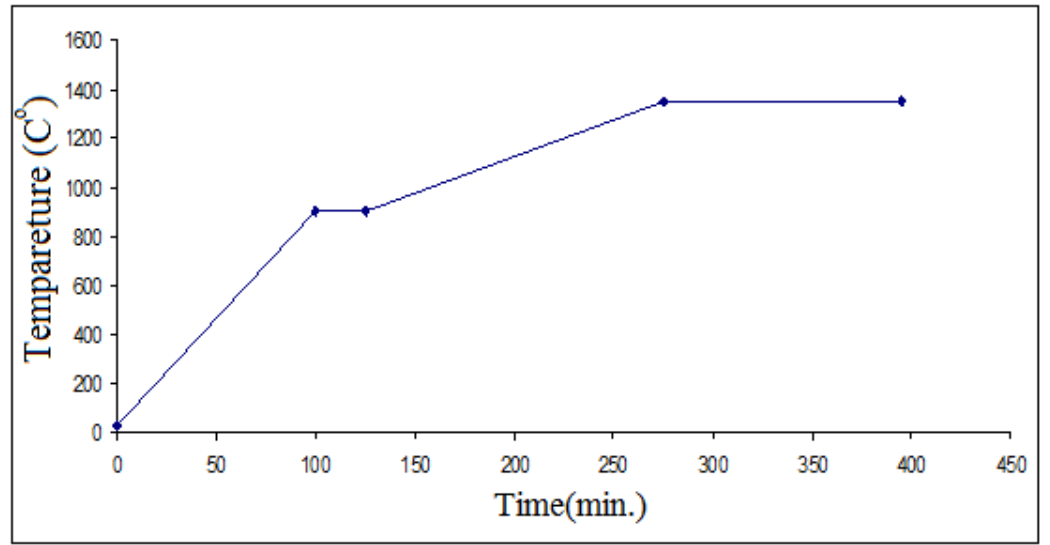
Figure 4: sintering program of pure Barium Titanate vs.